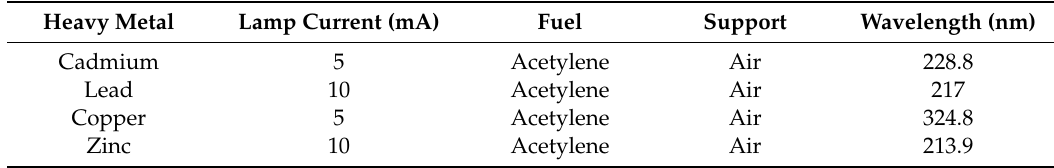
Table 3. Conditions for the measurement of heavy metal concentrations by atomic